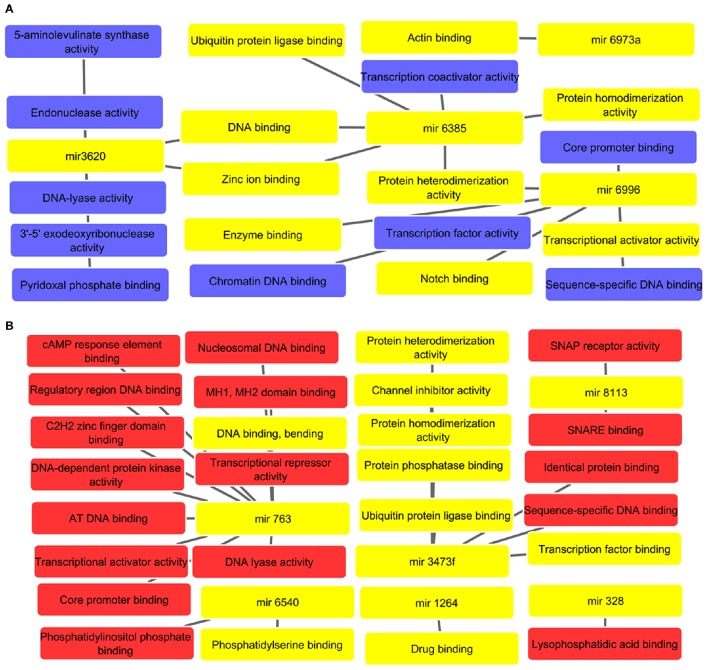
(A) Molecular network of up regulated miRNAs. All interlinked miRNAs and their respective targets have been highlighted with yellow color. The important molecular functions linked to cellular dysfunction such as DNA, enzyme and actin binding are highlighted with yellow color. (B) Analysis of molecular functions of down regulated miRNAs in L. donovani infected RAW 264.7 macrophages at 24 h post-infection with highlighted yellow color denoting important molecular functions such as drug binding, phosphatidylserine binding, protease, and transcription factor binding, etc.